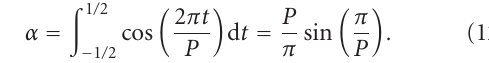
Figure 6: Comparison of reconstruction quality with di ff erent am- plitude correction methods for the peak amplitude sampling errors (output PSD for white